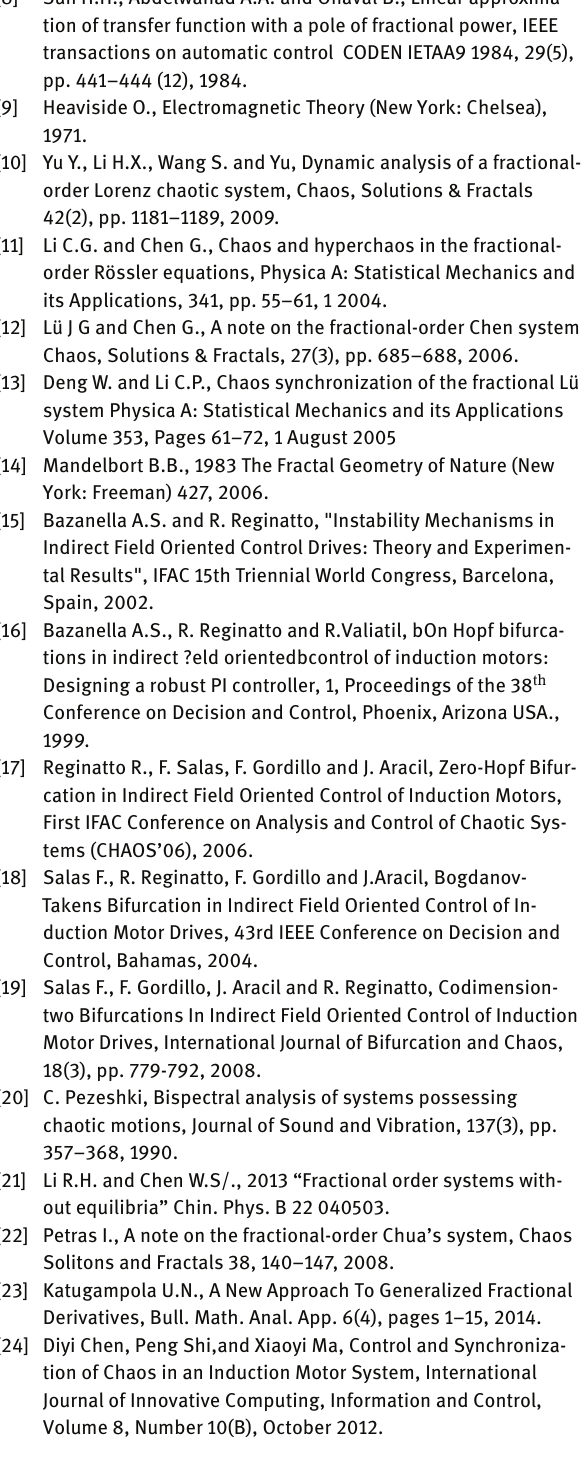
Fig. 4: State trajectories with control in action at t = 32.5 s.